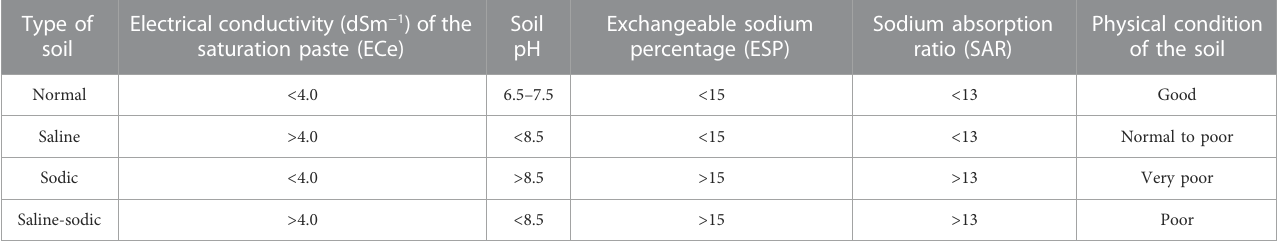
TABLE1Classi fi cationofsoilsalinitybasedonthereaction(pH),electricalconductivity(EC),exchangeablesodiumpercentage(ESP),andsodiumabsorptionratio(SAR) of the affected soil. Type of